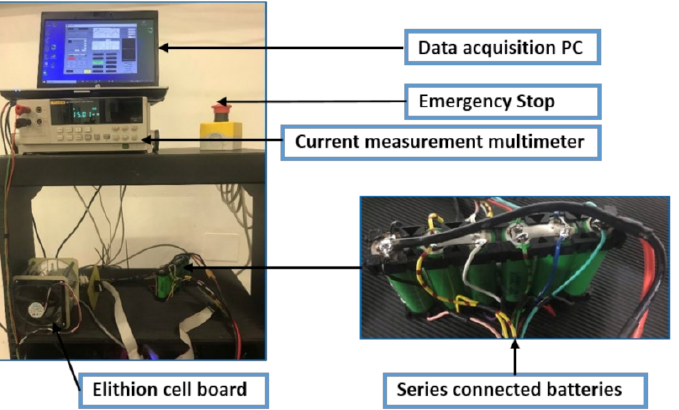
Figure 2. Experimental setup for data acquisition from lithium-ion batteries connected in